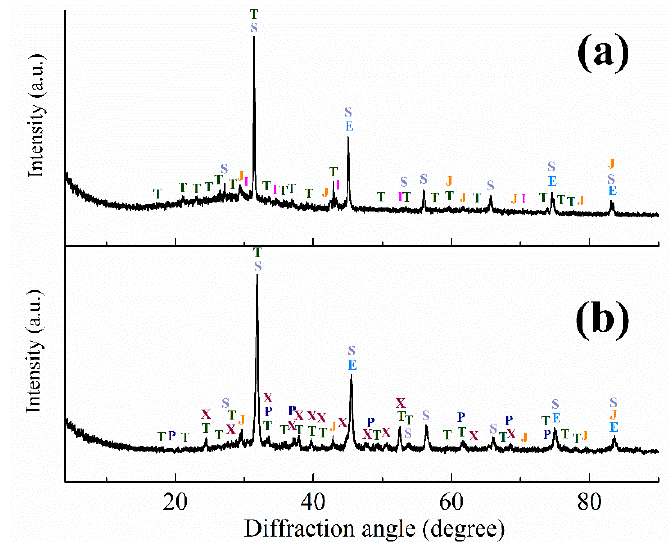
Figure 12. XRD patterns of the tailings obtained by roasting of red mud B at 1300 °C ( a ) and red mud U at 1400 °C ( b ) with 27.3% Na 2 SO 4 and 180 min duration time and following magnetic separation, where S—CaS; T—CaNaAlSi 2 O 7 ; X—Ca 2 Al 2 SiO 7 ; J—Na 2 S; P—CaTiO 3 ; E— α -Fe; I—FeS (troilite).